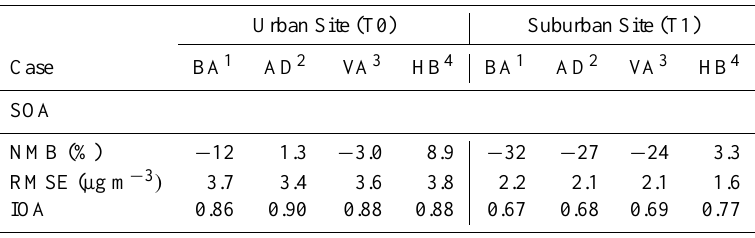
Table 2. Statistical comparison of measured SOA concentrations and simulations from sensitivity studies based on the NT2E-SOA model at T0 and T1 during the period from 24 to 29 March 2006.